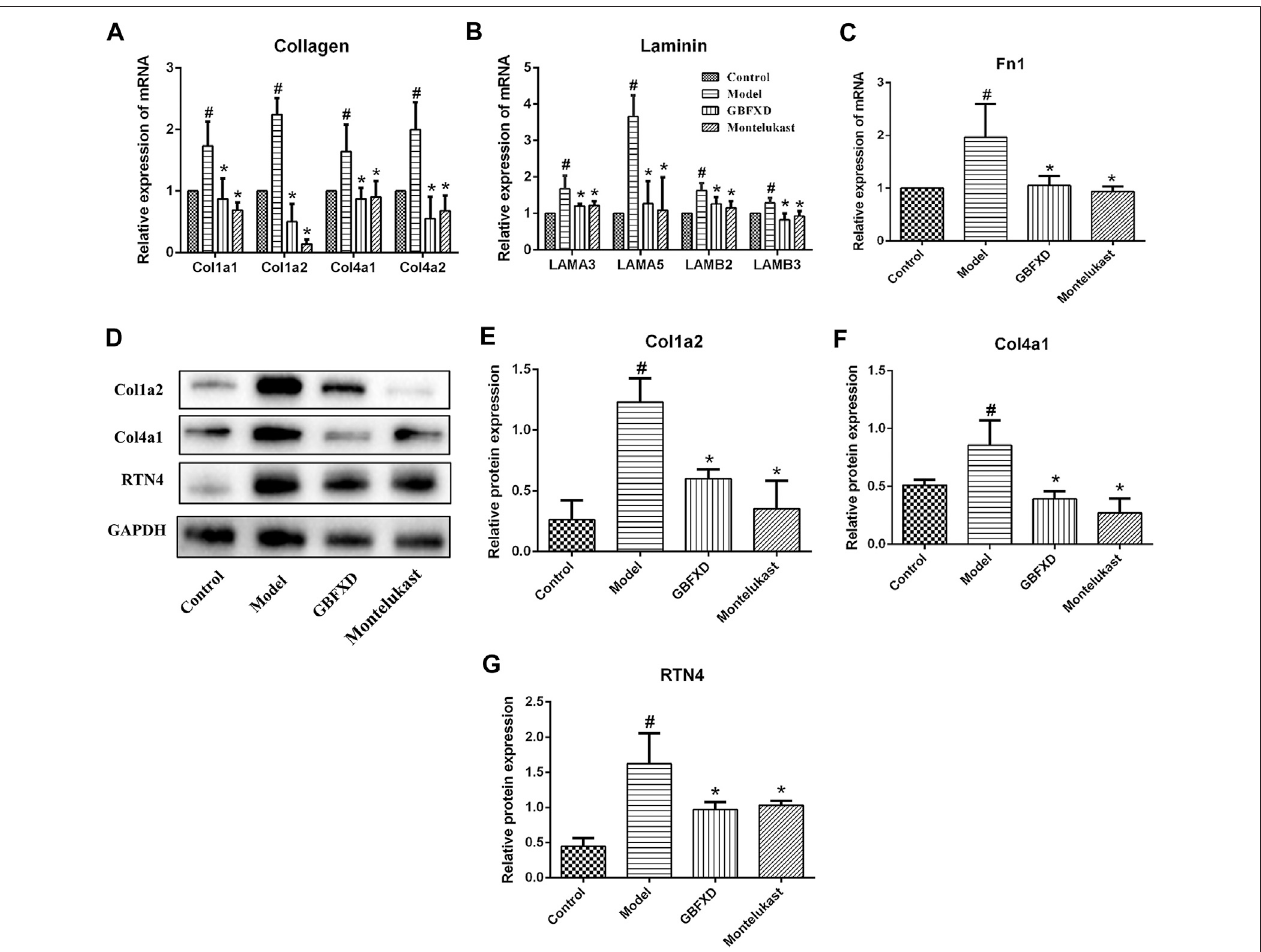
FIGURE 6 | Validation of DEPs identi fi ed in proteomics. (A – C) The mRNA levels of Collagen (Col1a1, Col1a2, Col4a1, Col4a2), Laminin (LAMA3, LAMA5, LAMB2, LAMB3) and Fn1 inlung weremeasuredbyReal-timePCR. (D) The proteins ofCol1a2, Col4a1, and RTN4 were analyzed byWestern Blot. (E – G) Quanti fi cationofCol1a2, Col4a1, and RTN4. Values are presented as mean ± SD ( n (cid:2) 3 or 4 mice per group). # p < 0.05 compared to control group, and * p < 0.05 compared to model group.